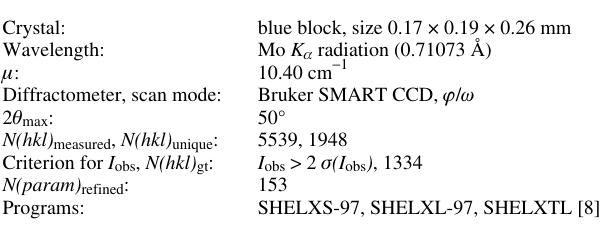
Table 1. Data collection and handling.